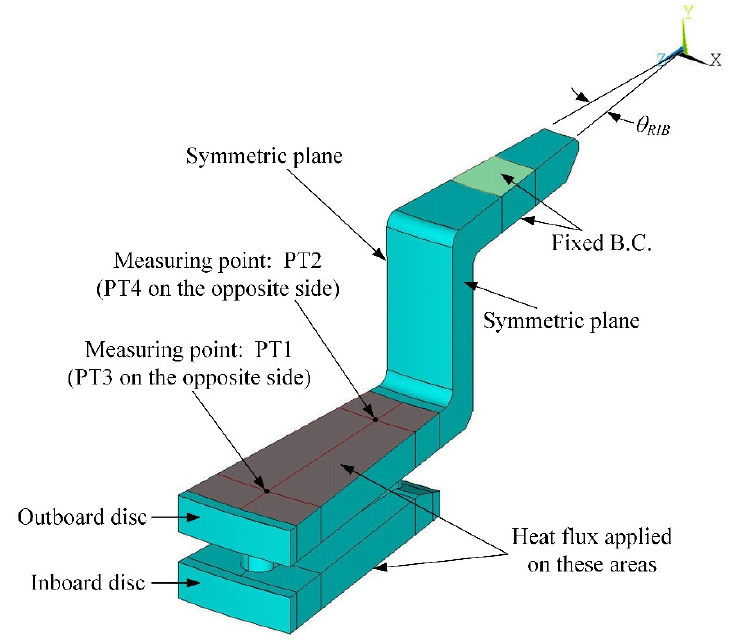
Figure 11. A sliced rotor model and its boundary conditions.